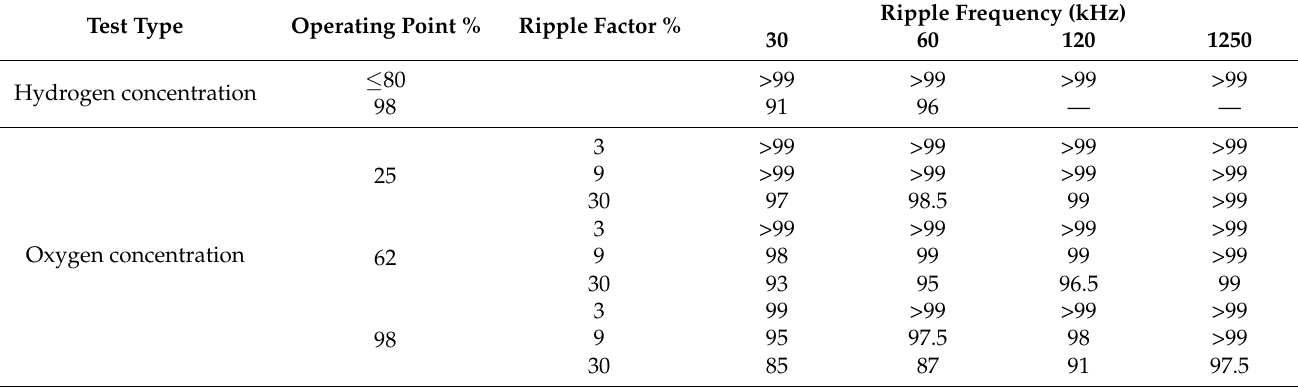
* Efficiency corresponds to percentage of utilization, measured as concentration of hydrogen and oxygen at